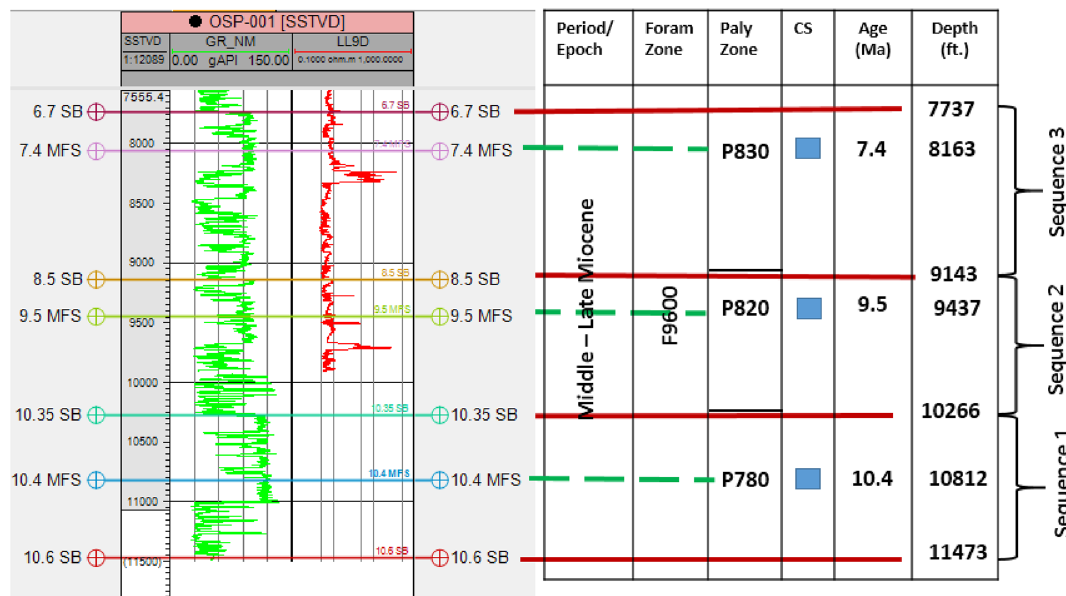
Fig. 8 Key stratigraphic surface identified in OSP-001